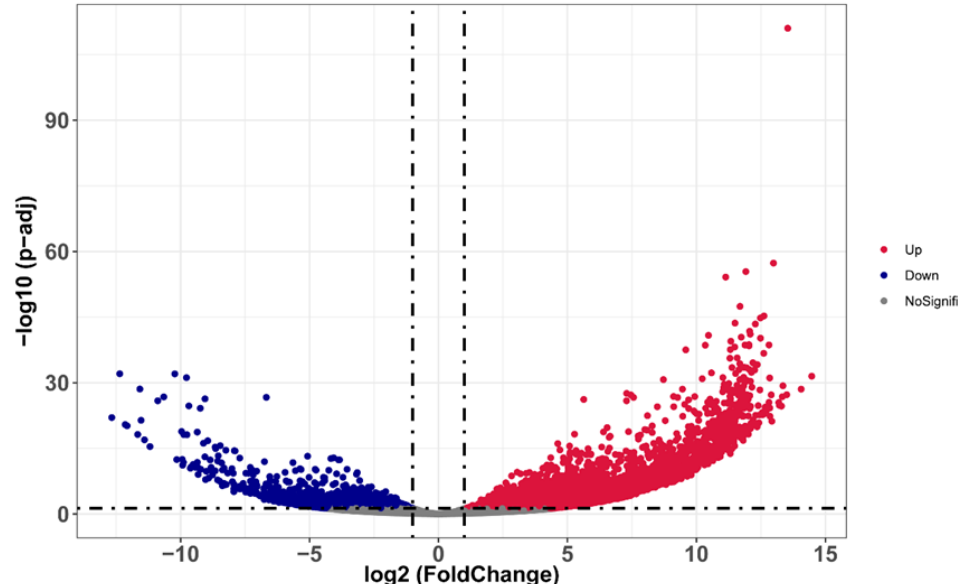
Figure 1. Total DEGs in the dataset. Red indicates up-regulated genes in males (male-biased genes), and blue indicates up-regulated genes in females (female-biased genes).